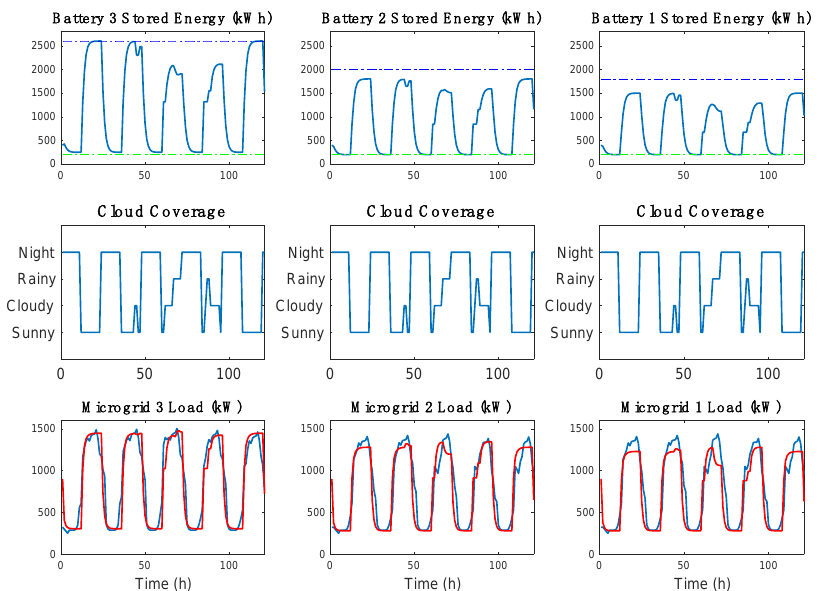
Figure 3. Simulation results when the microgrids are disconnected : battery energy variation (top fig- ure), cloud coverage (middle figure), commercial load (blue) and load power usage (red) (bottom figure). The upper and lower dashed lines represent the minimum and maximum battery energy storage, respectively.